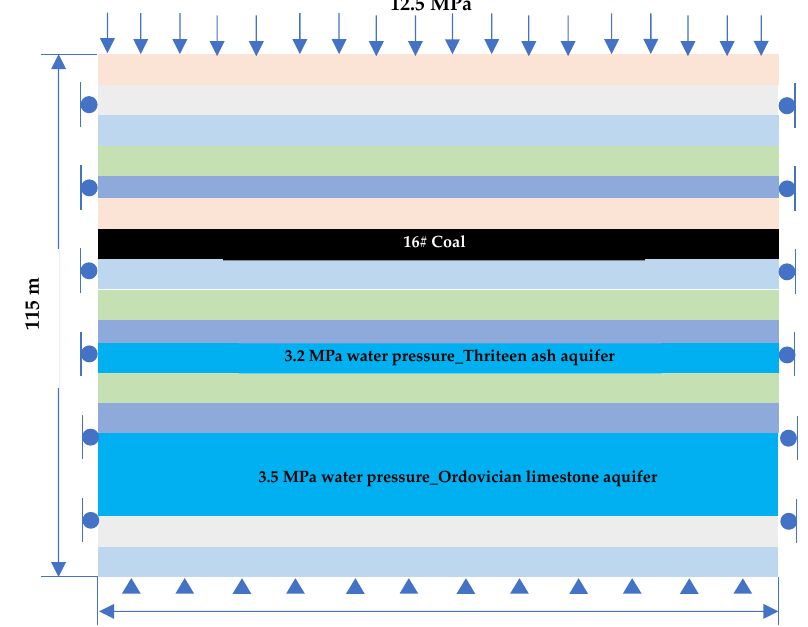
Figure 5. Geometric model diagram. Table 2. Mechanical parameters of rock mass of the model.